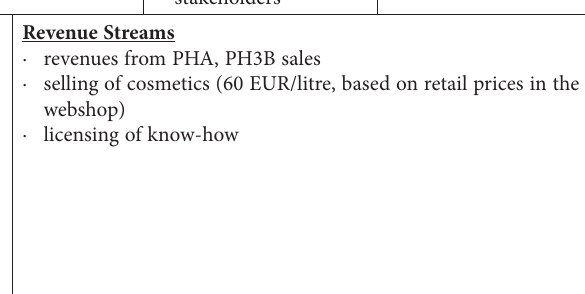
Figure 8. BMC of solution ‘S6’ (NAFIGATE Corporation, Czech